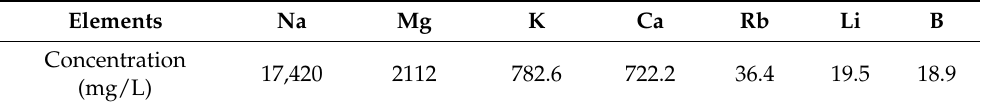
Table 2. The main elements and the concentrations of desalination